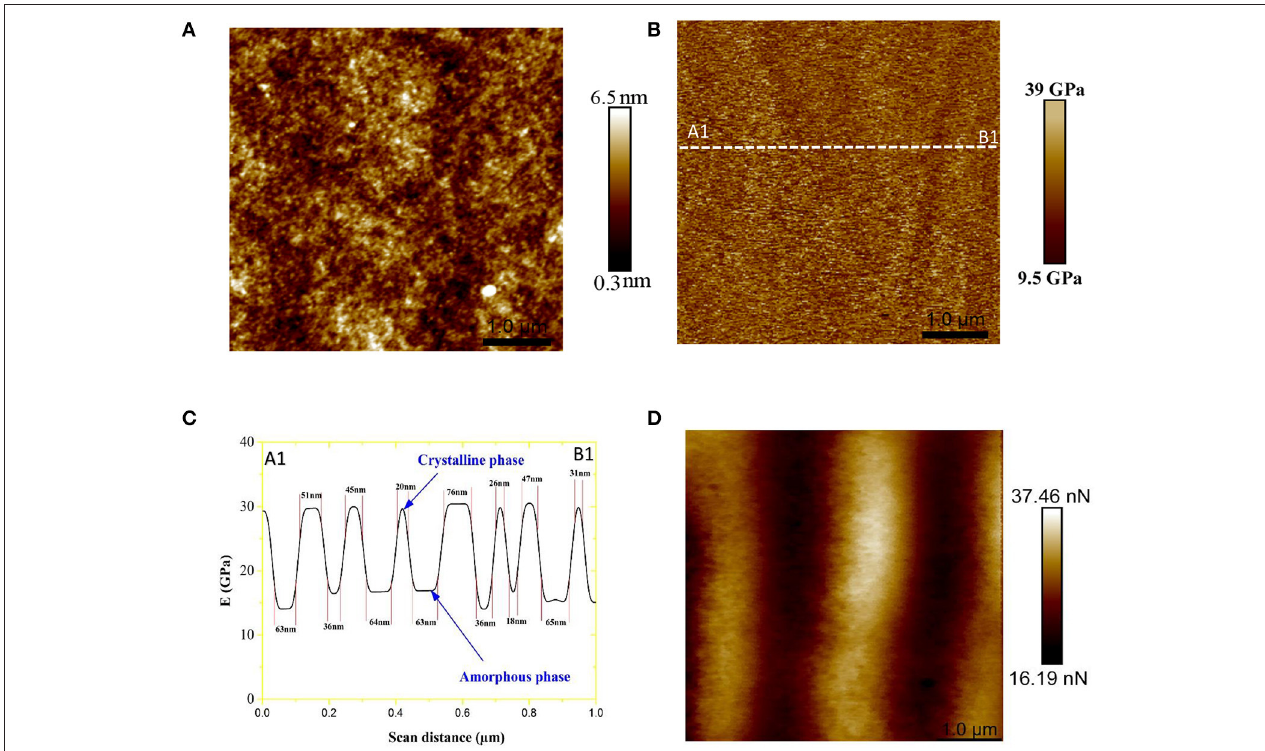
FIGURE 2 | 2D AFM mapping images of PVA films for (A) height and (B) DMT modulus, (C) DMT modulus-scan distance curve for corresponding typical section A 1 -B 1 in (B) and (D) 2D adhesion mapping image of PVA films.